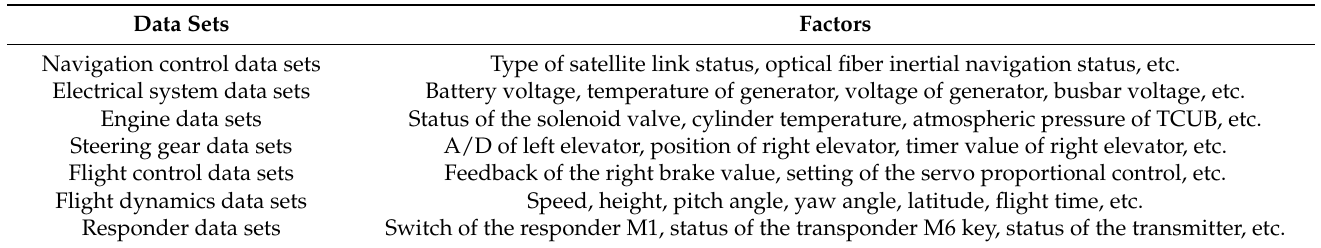
Table 1. More than 500 factors are contained in each data set. Data Sets Factors Navigation control data sets Type of satellite link status, optical fiber inertial navigation status, etc. Electrical system data sets Battery voltage, temperature of generator, voltage of generator, busbar voltage, etc. Engine data sets Status of the solenoid valve, cylinder temperature, atmospheric pressure of TCUB, etc. Steering gear data sets A/D of left elevator, position of right elevator, timer value of right elevator, etc. Flight control data sets Feedback of the right brake value, setting of the servo proportional control, etc. Flight dynamics data sets Speed, height, pitch angle, yaw angle, latitude, flight time, etc. Responder data sets